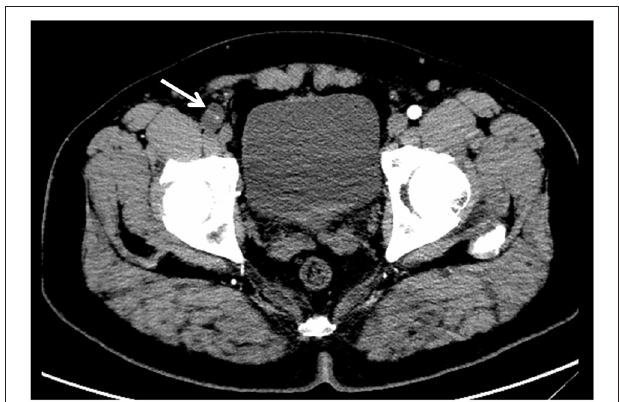
FIGURE 1 | Preoperative, pelvic, contrast-enhanced CT imaging showed a low-density shadow next to the common femoral artery, and the common femoral artery was almost completely occluded (white arrow).